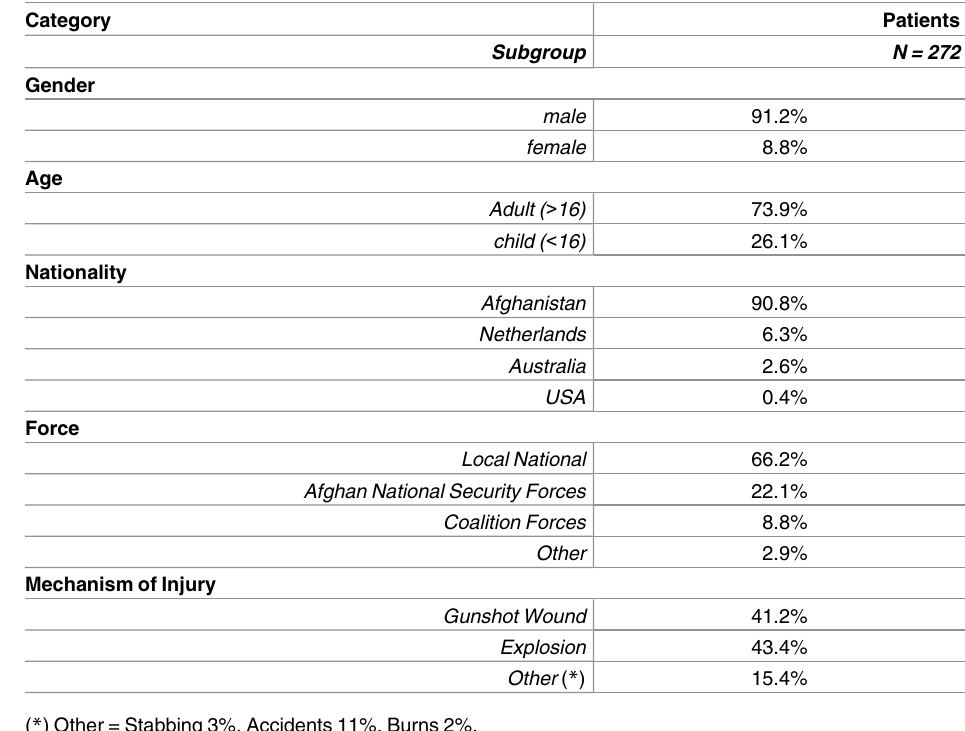
Table 1. General Patient